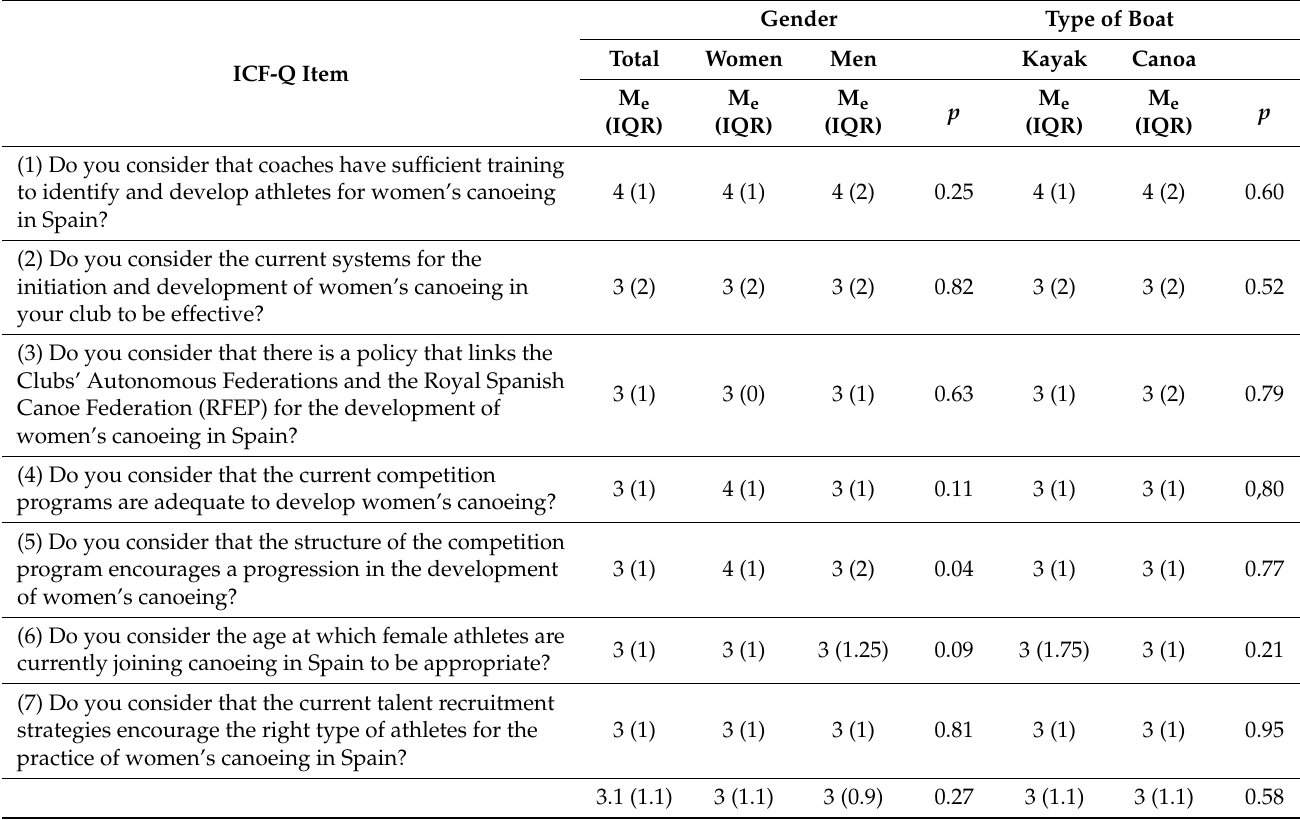
Table 4. Descriptive analysis and differences by gender and sport modality of the ICF-Q